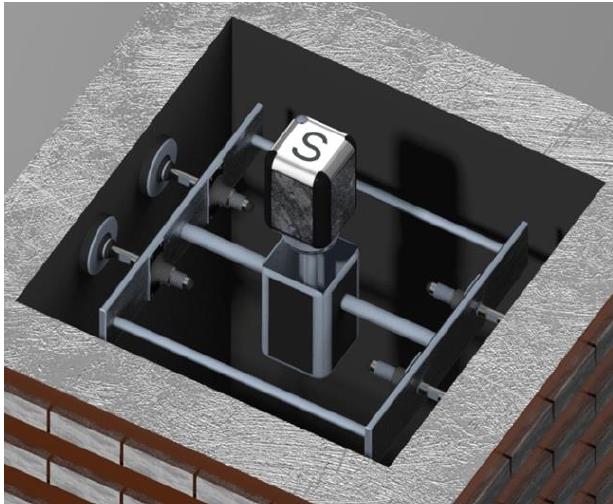
Figure 3. Design 1 - Rectangular